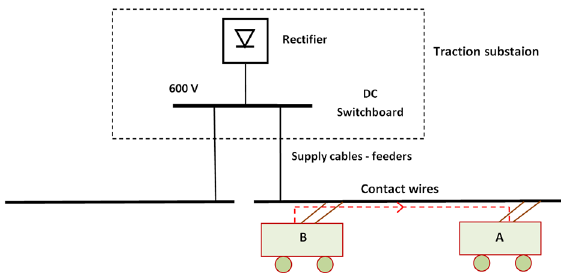
Fig. 5. Regenerative braking energy flow in case of vehicles on different power supply sections of the same traction substation